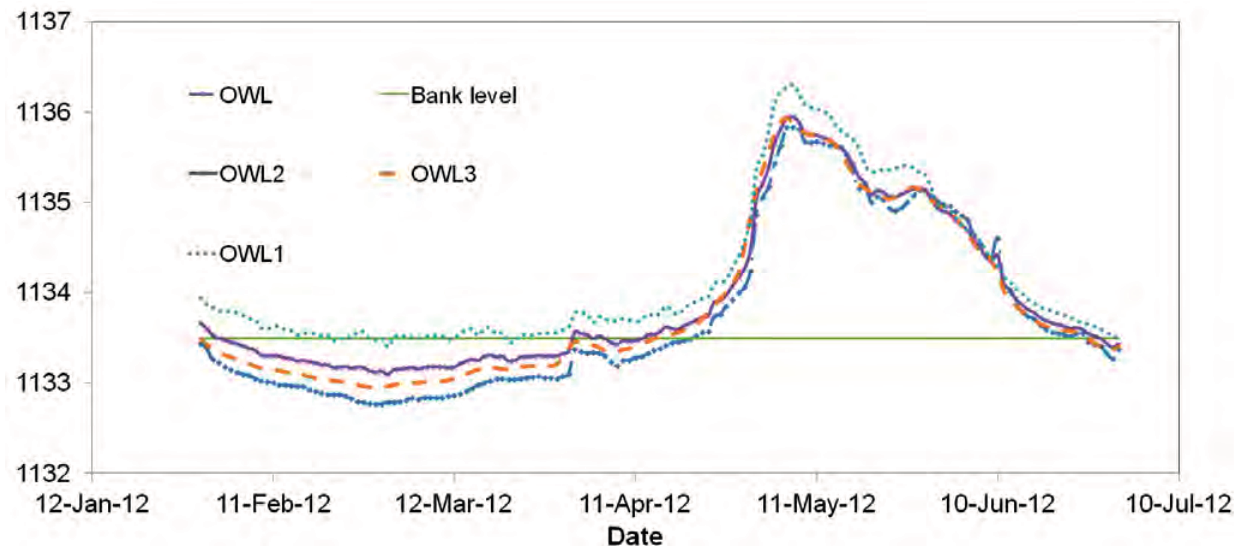
Figure 14. Observed and simulated hydrographs for three simulations SWL1, SWL2 and SWL3. Table 7. Model performance parameter as per different Manning’s roughness parameterizations. SWL1 is simulated water levels with optimum floodplain roughness (n p ) with channel roughness n c = 0.03 m − 1/3 /s, SWL2 is simulated water levels with calibrated values for